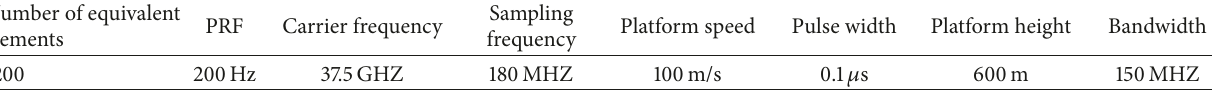
Table 4: Simulation parameters of carrier aircraft